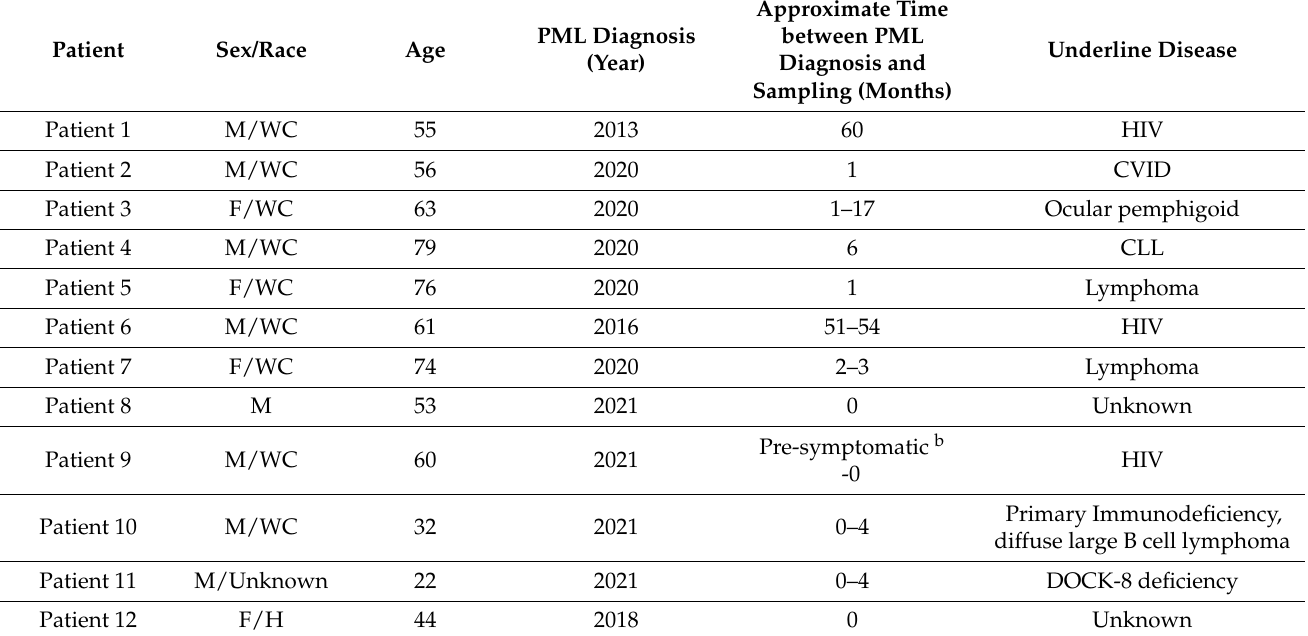
Table 1. Demographic and clinical characteristics of the 31 PML patients. Approximate time between PML diagnosis and sampling is given in months, with a range indicating sampling over multiple time